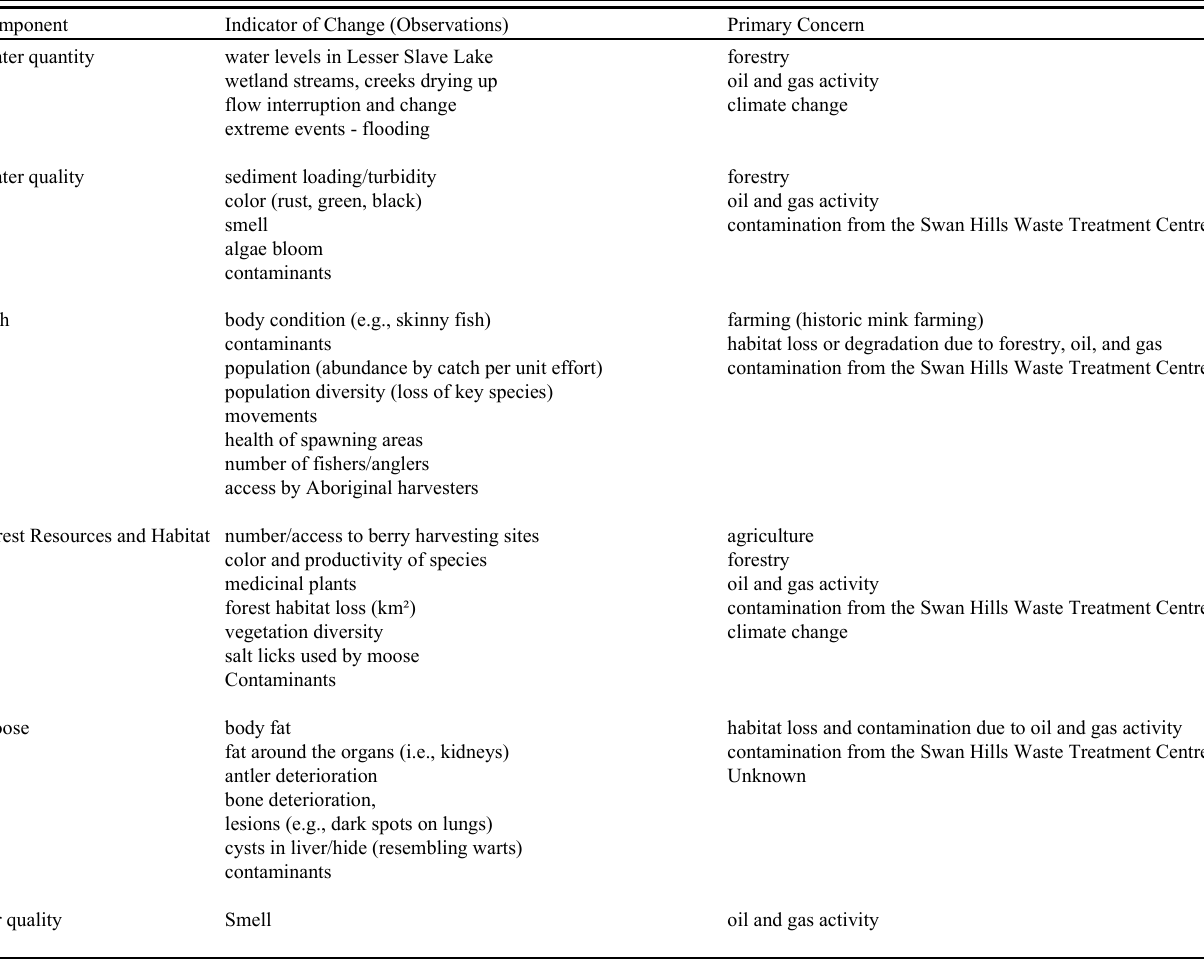
Table 1. Key themes and indicators and resource development